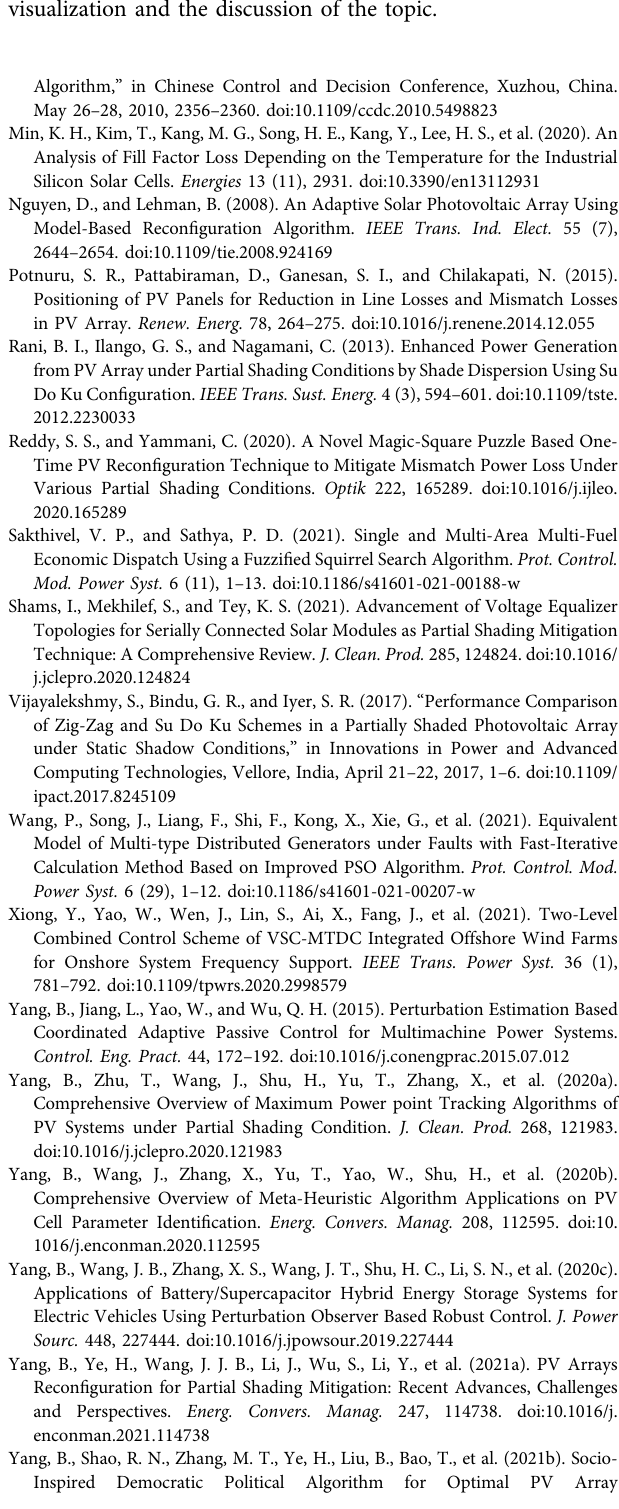
algorithm-based recon fi guration approaches, there is an urgent need to develop an effective and ef fi cient control algorithm to apply a recon fi guration technique to meet the needs of a practical engineering